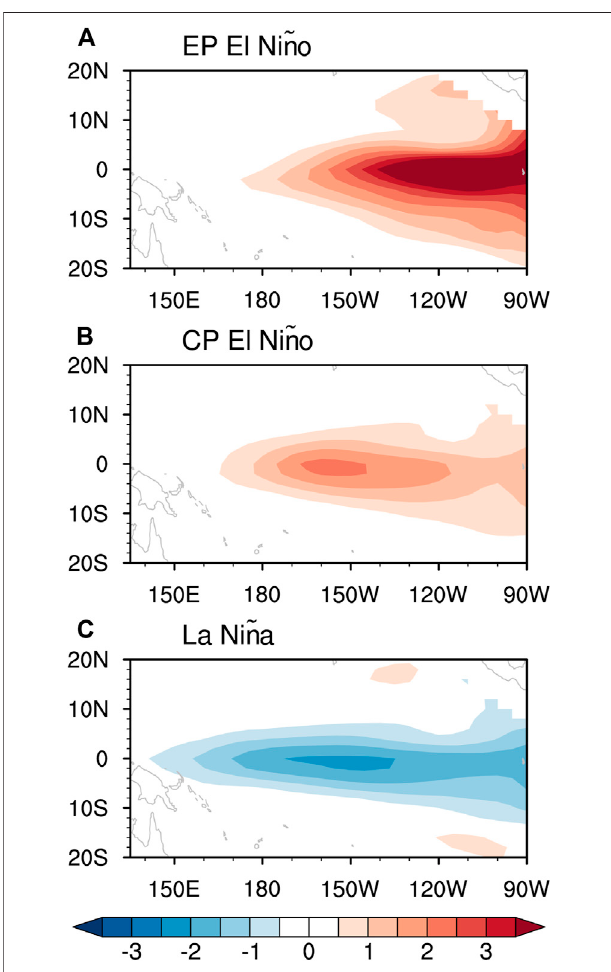
FIGURE14| CompositesofSSTApatternatthepeakphaseof (A) EPEl Niño, (B) CP El Niño, and (C) La Niña. See text for criteria of the El Niño/La Niña